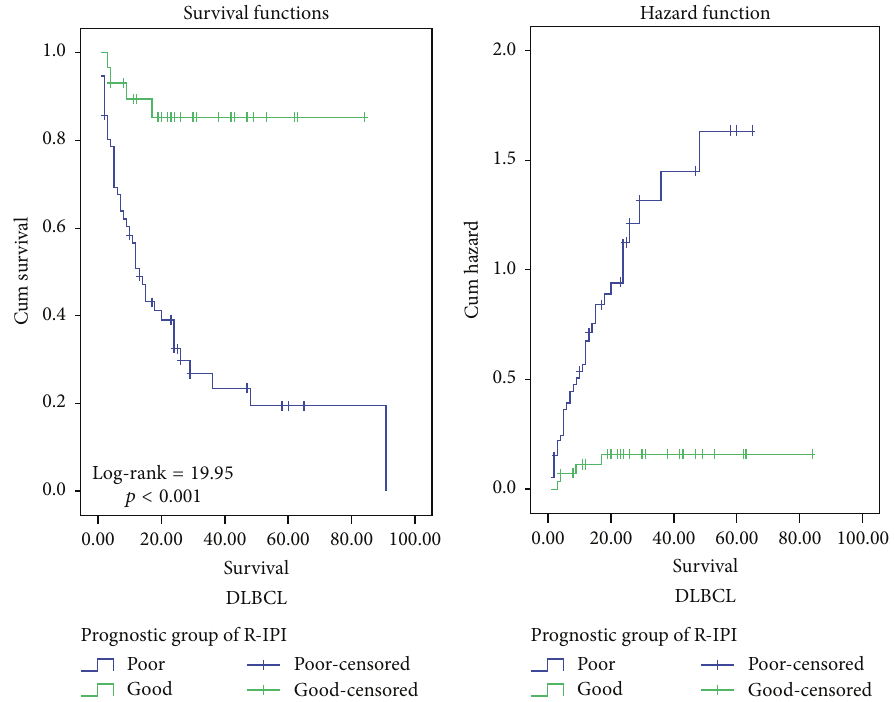
Figure 6: Kaplan-Meier and hazard function curve of OS for DLBCL patients with different categories of prognostic group of R-IPI indicating that poor prognostic group was more